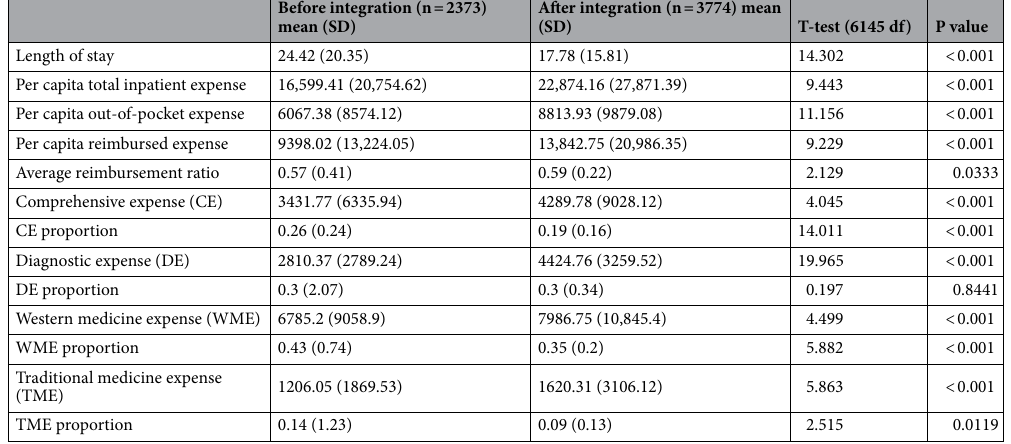
Table 2. Main indicators for the integrated medical insurance in Jiujiang.